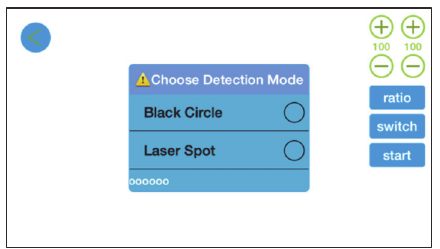
Figure 1: Initial setup interface.